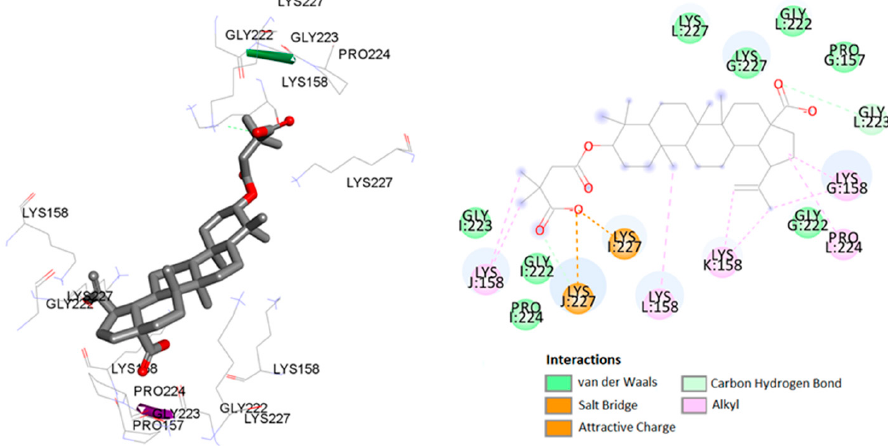
Figure 6. Predicted binding model of BVM with the HIV-1 CA CTD-SP1 protein.